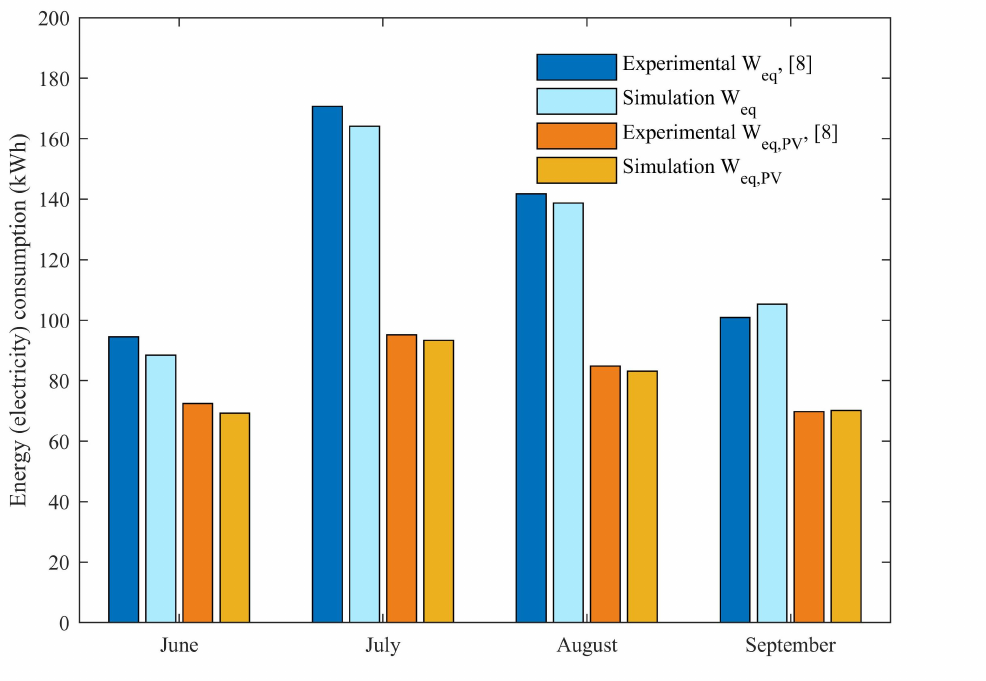
Figure 8. Comparison between experimental and predicted results. Monthly total energy consump- tion ( W eq ) and monthly PV energy consumption ( W eq,PV